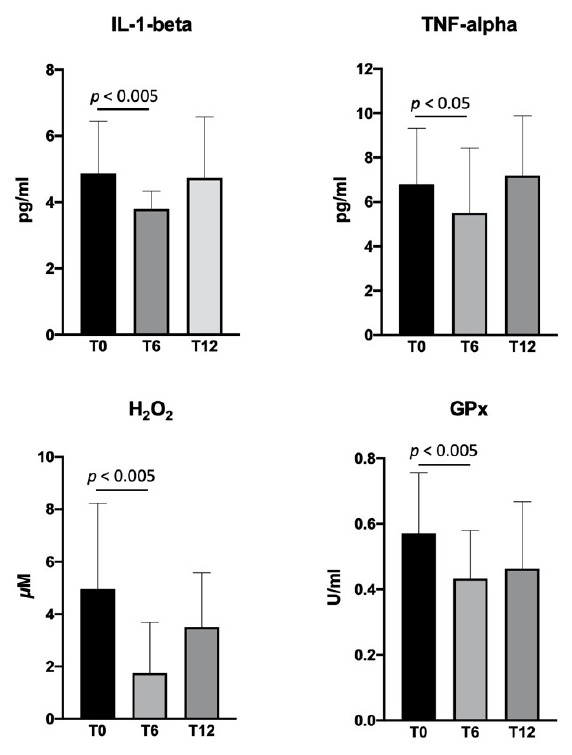
Figure 3. Levels of serum interleukin (IL)-1 beta, tumor necrosis factor (TNF)-alpha, H 2 O 2 , and glutathione peroxidase (GPx) measured in DMD patients ( n = 17) at baseline (T0) and after 6 (T6) and 12 (T12) months of treatment with flavocoxid. Data are expressed as mean ± SD.